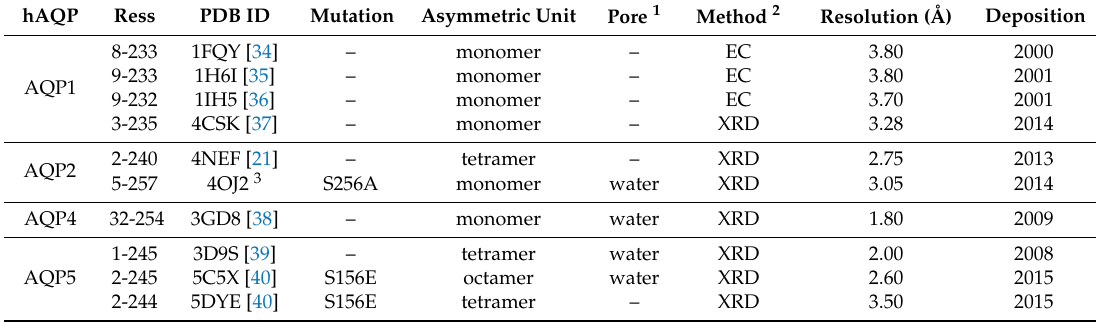
Table 1. Experimental 3D structures available for human AQPs from the wwPDB (worldwide Protein Data Bank, last update on January